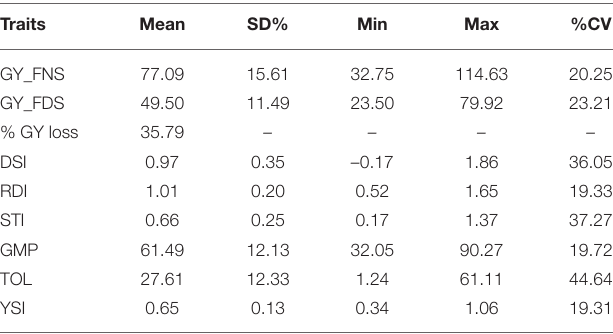
TABLE 2 | Descriptive statistics for grain yield (GY) drought